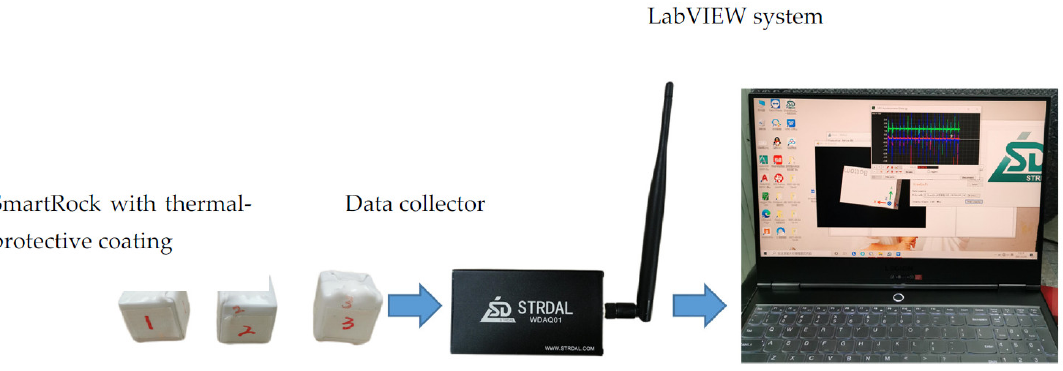
Figure 4. Data collection system.